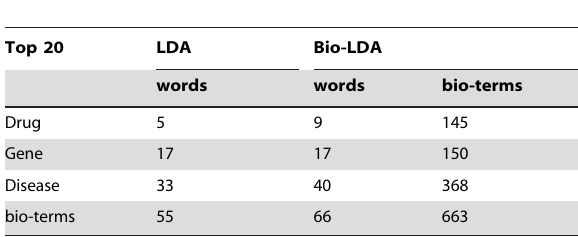
Table 6. Bio-terms associated with